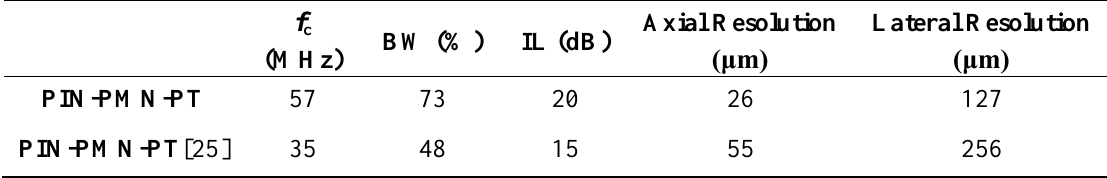
Table 3. Summary of the performance of PIN-PMN-PT transducers at room temperature [64].